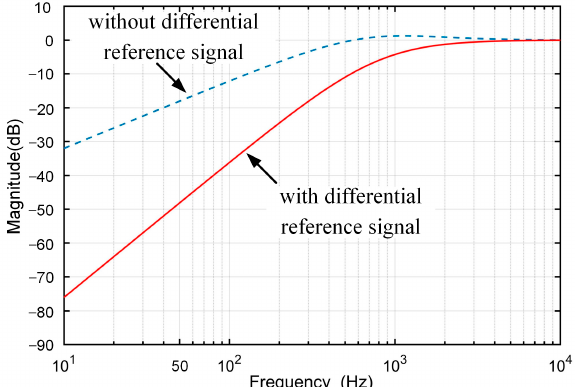
Figure 4. Bode magnitude diagram of tracking error transfer function with and without differential reference ( ω o = 5000 rad/s).